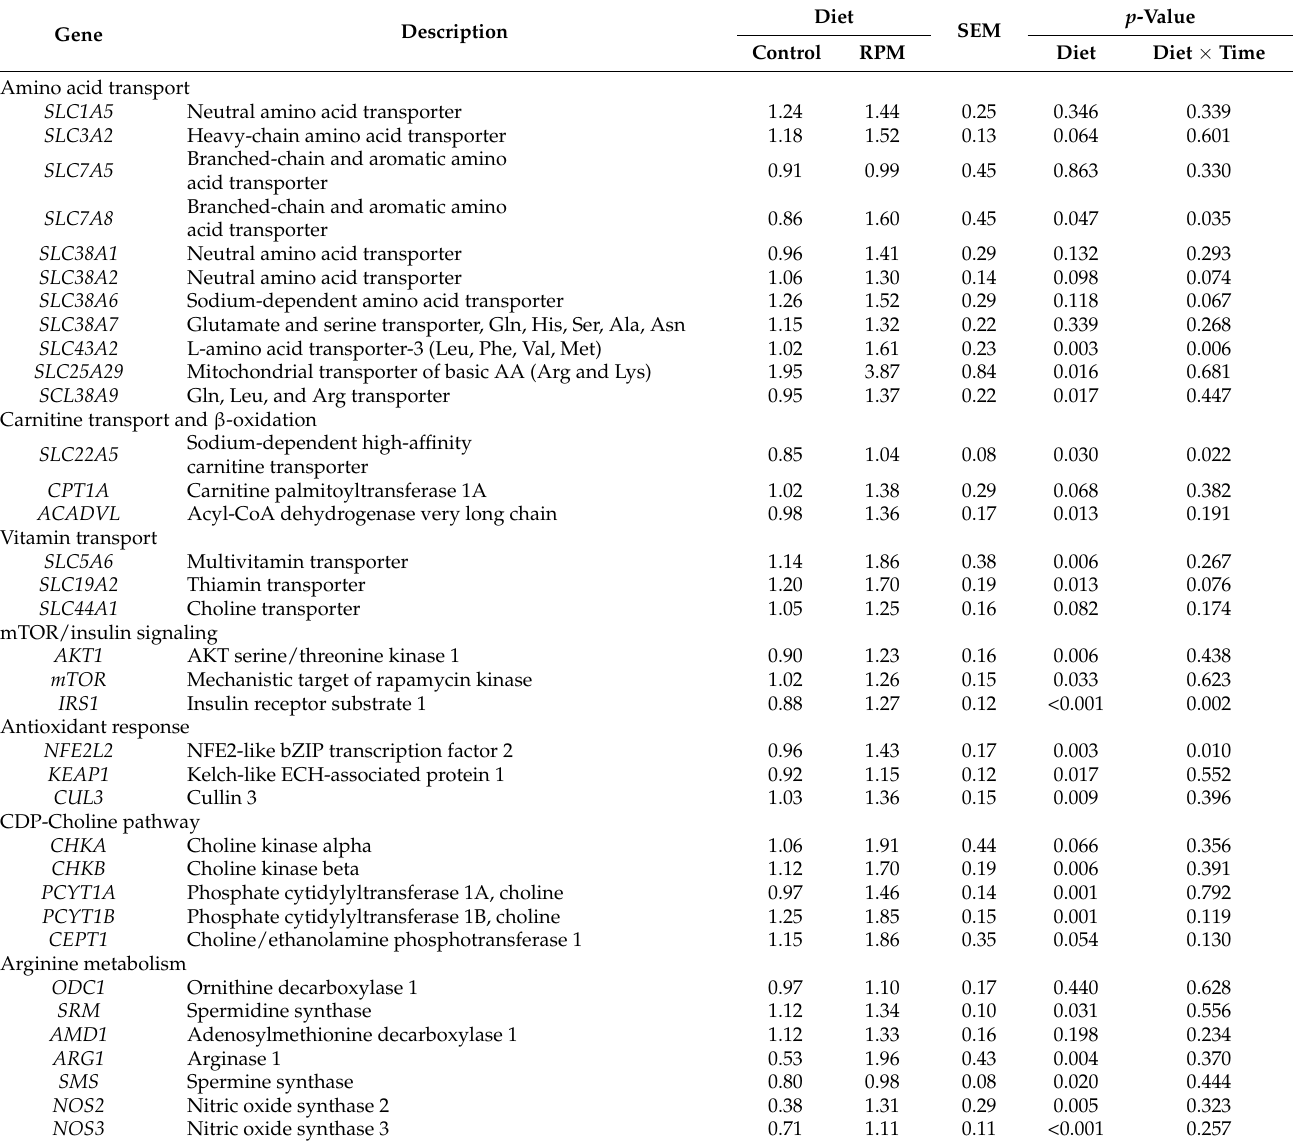
Table 2. mRNA expression of genes in skeletal muscle of dairy cows ( n = 10/diet) fed a basal control diet or the basal diet plus ethyl-cellulose rumen-protected methionine (0.9 g/kg DMI at prepartum and 1.0 g/kg DMI at postpartum) from − 21 to 21 day of calving. Statistical p -values for the main effect of time are reported in the figures in the Supplemental File (Figures